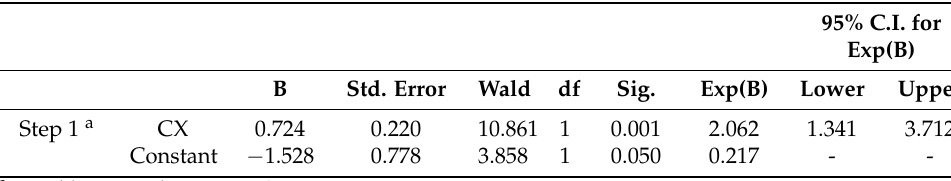
Table 15. Technology complexity: regression analysis for private